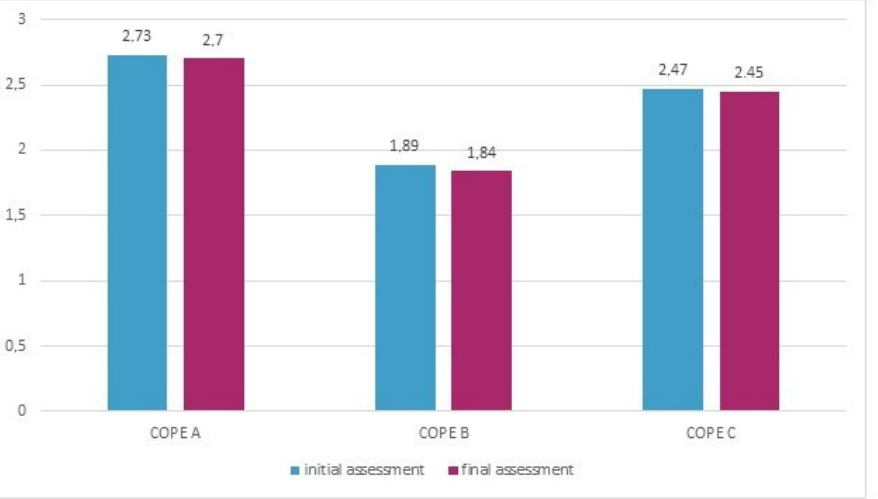
Figure 3. The use of general coping strategies (according to the COPE) in the study group in the initial and final initial and final assessments.